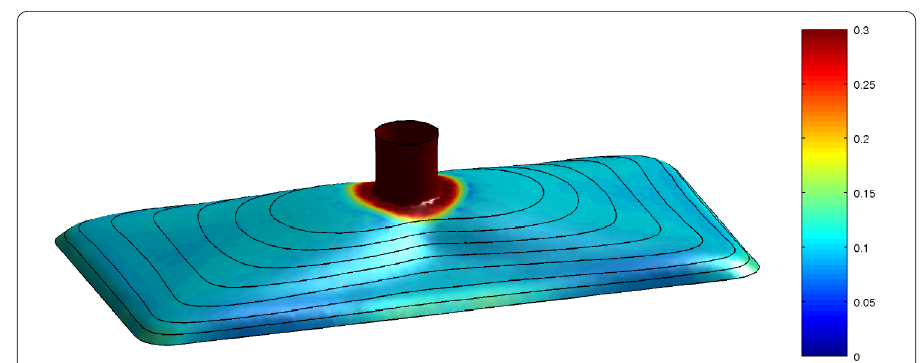
Figure 3 Cavity A: Optimal distributor geometry for a target wall shear stress of σ d = 0.1